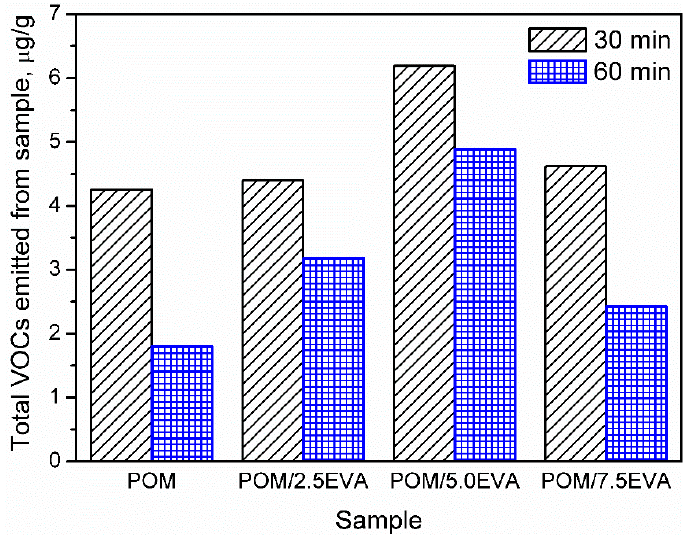
Figure 2. Values of the total volatile organic compounds (TVOCs) parameters for investigated polyoxymethylene (POM)/ethylene-vinyl acetate (EVA) blends.